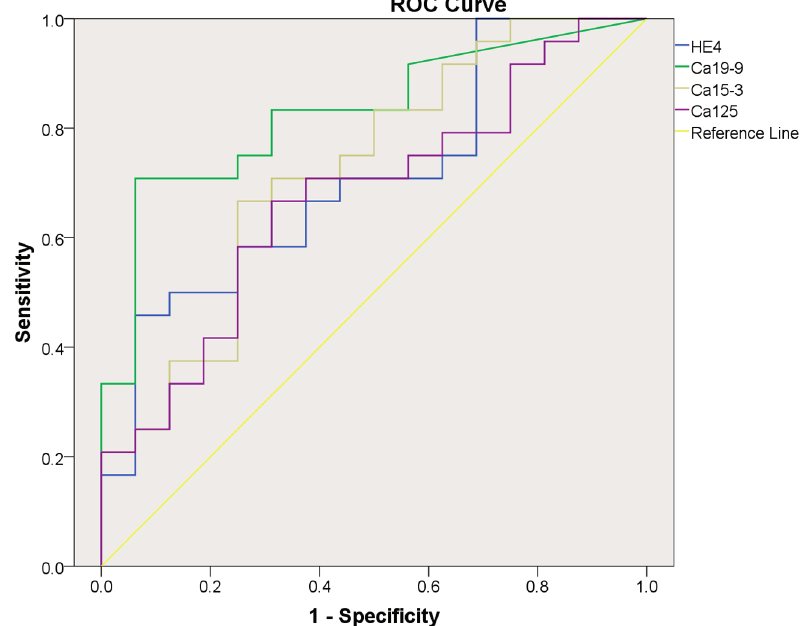
Figure 4. Receiver-operating characteristic (ROC) curves of serum HE4, CA19-9, CA15-3 and CA125. ROC curve of each marker was drawn based on the ELISA results from normal controls and pancreatic adenocarcinoma patients’